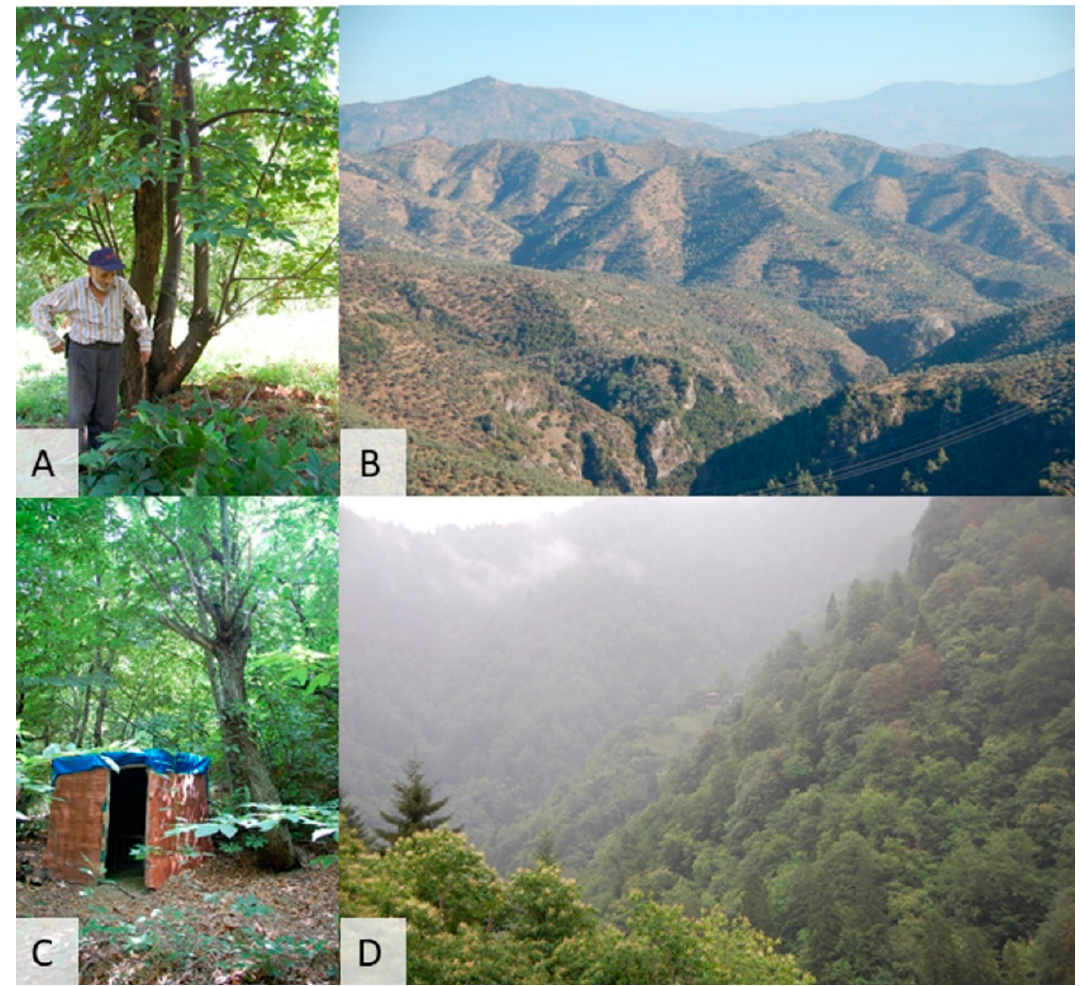
Figure 5. Clockwise from top left, ( a ) Bursa province grower in his seventeen-year-old grafted orchard of blight-resistant European-Japanese hybrid and ( b ) new lands of the 49-year leases (kırk dokuz yıllı˘gına kiralık) in Aydın; ( c ) Sayvan, that is, huts found in maintained chestnut groves on state land in Zonguldak province, and ( d ) chestnut inflorescence in the highlands of the eastern Black Sea province of Rize.